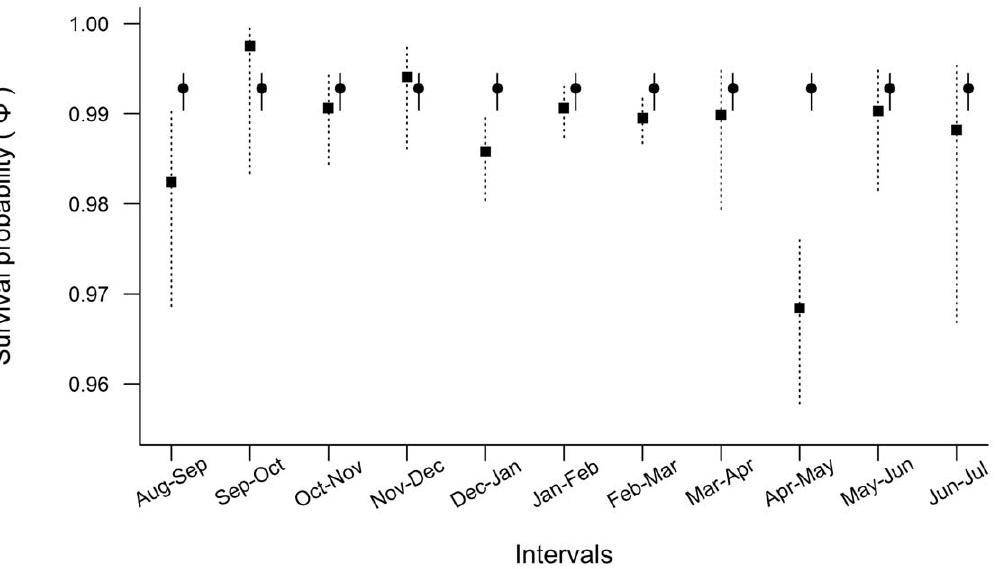
Figure 5. Apparent survival probability estimates for Iporangaia individuals according to their parental state. Vertical lines represent 95%CI of the monthly estimates, solid squares and dotted lines represent estimates for non-caring individuals (males and females), while solid circles and solid lines represent estimates for caring males.